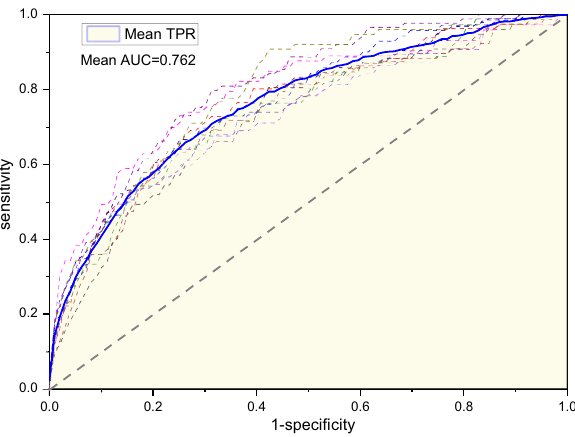
Figure 4. ROCs, mean ROC, and AUC with tenfold cross-validation of the XGBoost